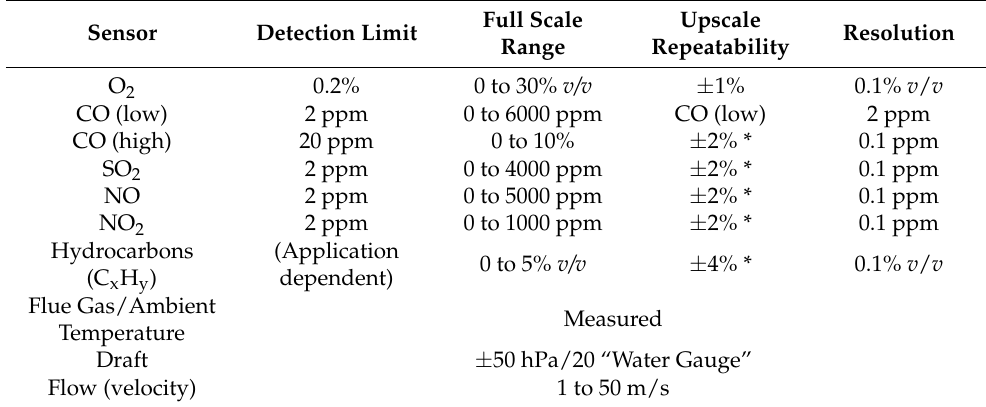
Table 1. Measurement specifications of the Lancom 4 Portable Flue Gas Analyzer.